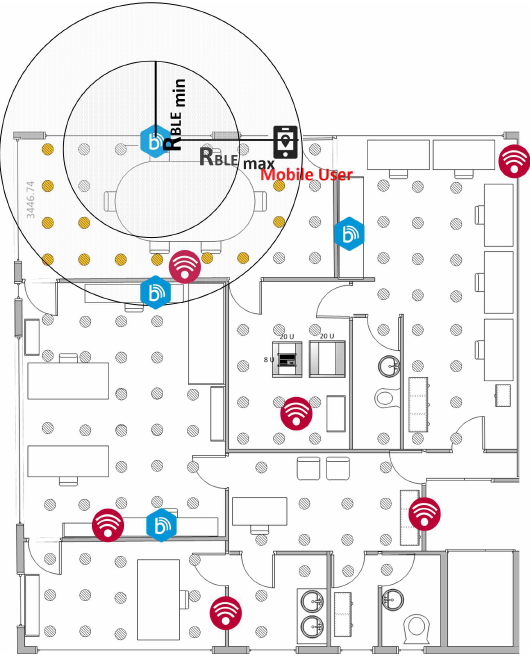
Figure 2. Combined BLE and Wi-Fi fingerprint based indoor